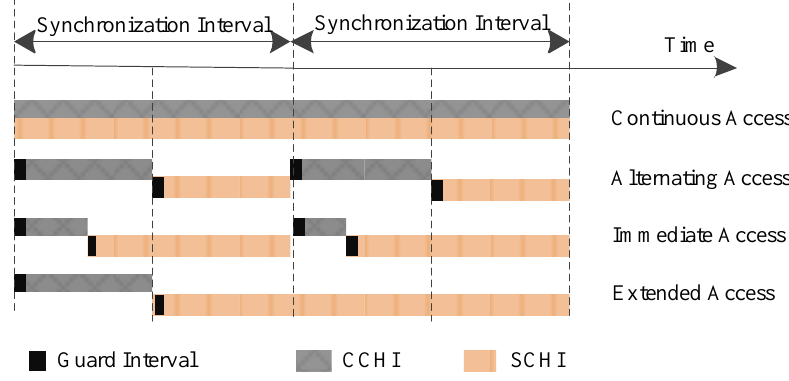
Figure 8. WAVE channel-access operation.